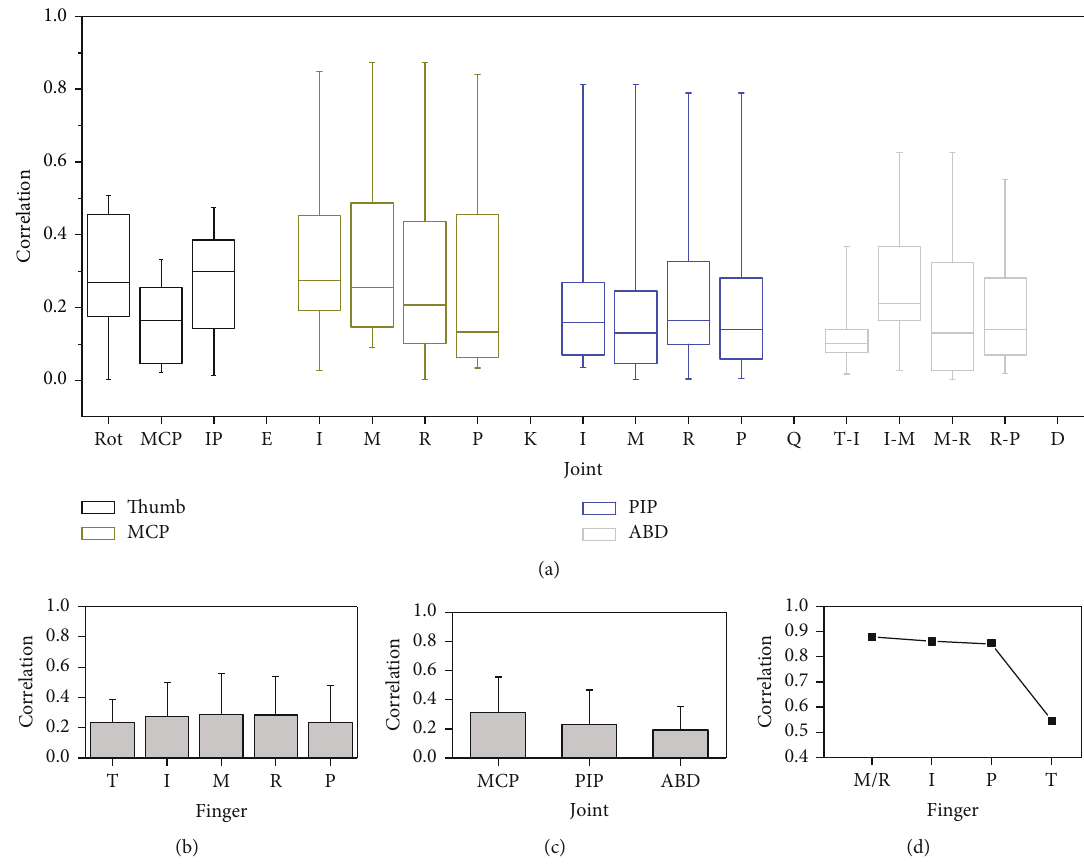
Figure 2: Correlation analysis of each joint movement for all subject data totally: (a) distribution of each joint correlation, (b) fi nger movement correlation, (c) joint movement correlation, and (d) the highest correlation to fi nger/joint. T, I, M, R, and P represent the thumb, index, middle, ring fi nger, and pinky; T-I, I-M, M-R, and R-P represent the ABD joint between the adjacent fi ngers from the thumb-index fi nger to ring fi